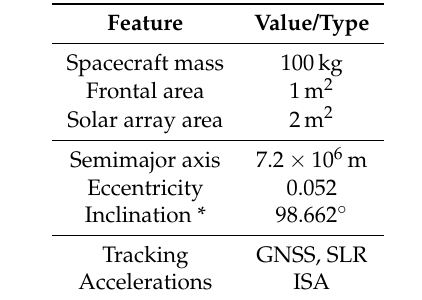
Table 3. Main features of the proposed configuration for